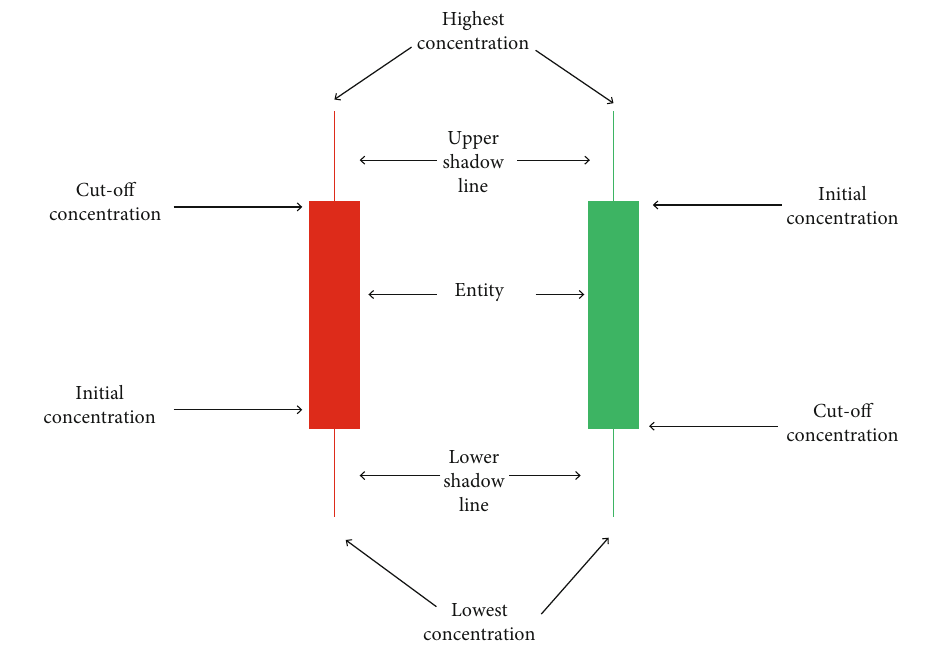
Figure 1: Sketch diagram of K-line. Table 1: Graphics of the K-line diagram and their